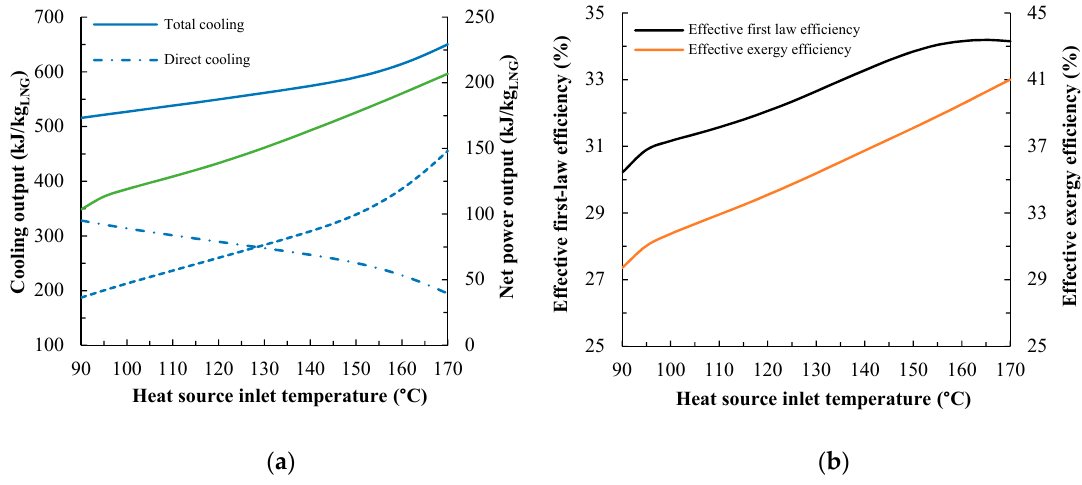
Figure 3. Effect of heat source inlet temperature on poly-generation system performance: ( a ) Useful cooling and electrical power outputs; ( b ) Overall efficiencies.